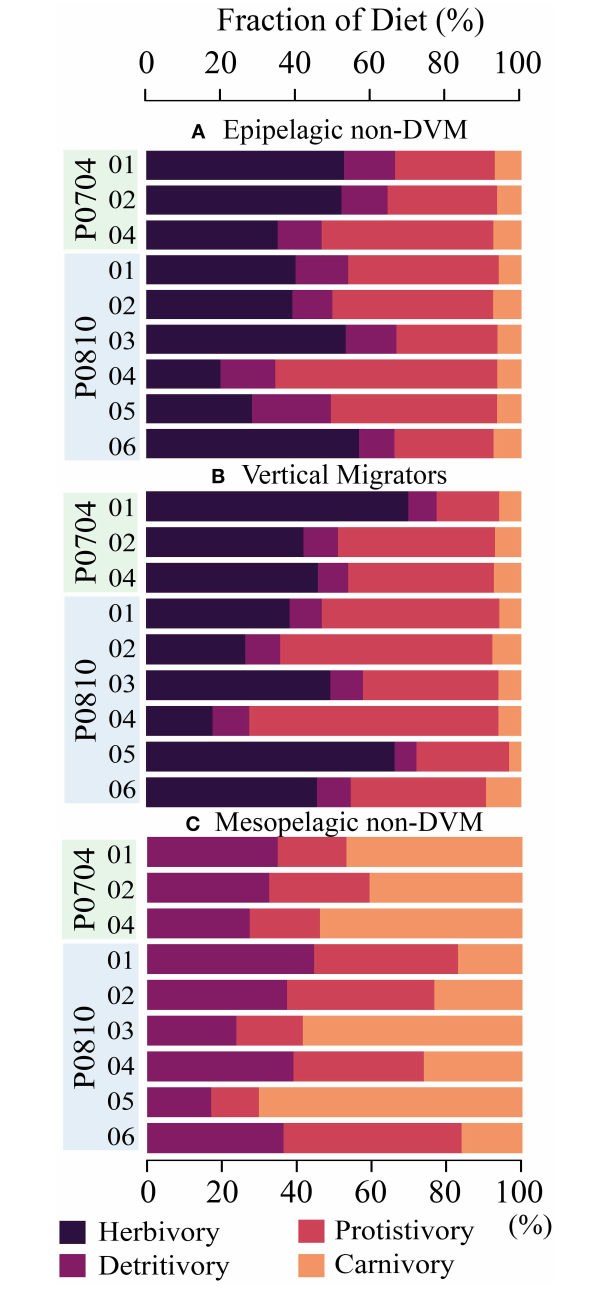
transport ( Figure 8B ). However, mesopelagic nekton (dMYC) were predominantly supported by carbon derived from active transport